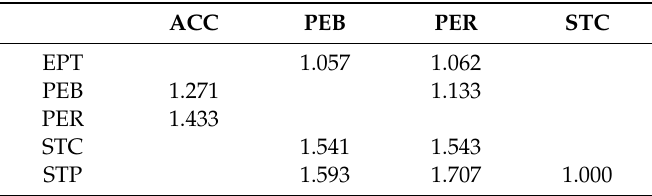
Table 6. Variance inflation factors (VIFs) of the